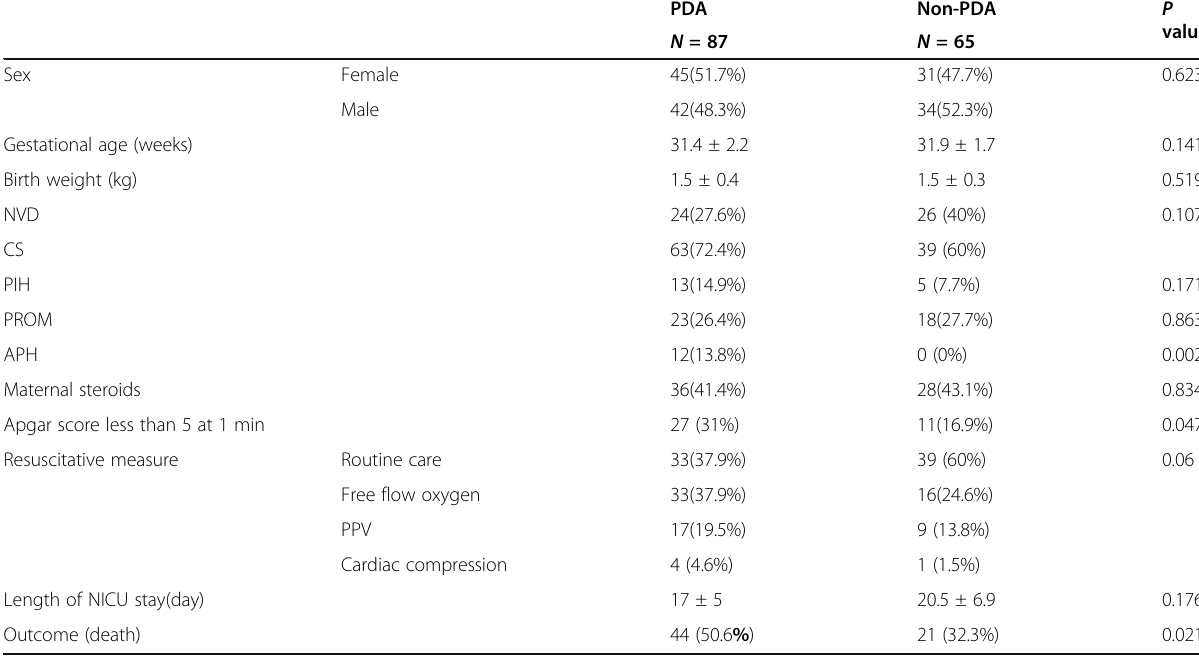
Table 1 Demographic and resuscitative data of the studied population